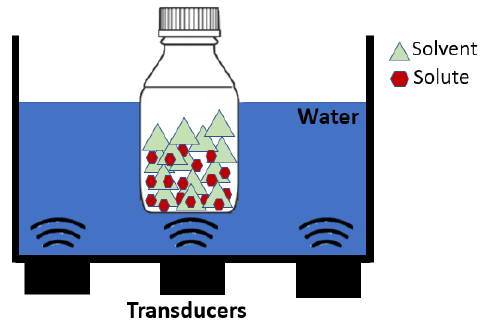
Figure 4. Scheme of the ultrasonic bath for UAE.